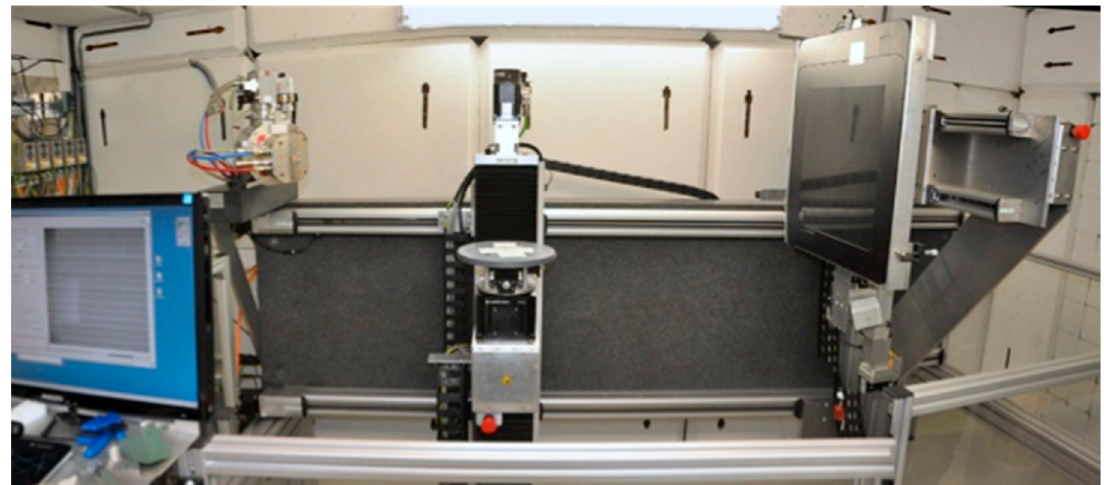
Figure 17. A micro-computed tomography ( μ CT) system in use at Ghent University [285].